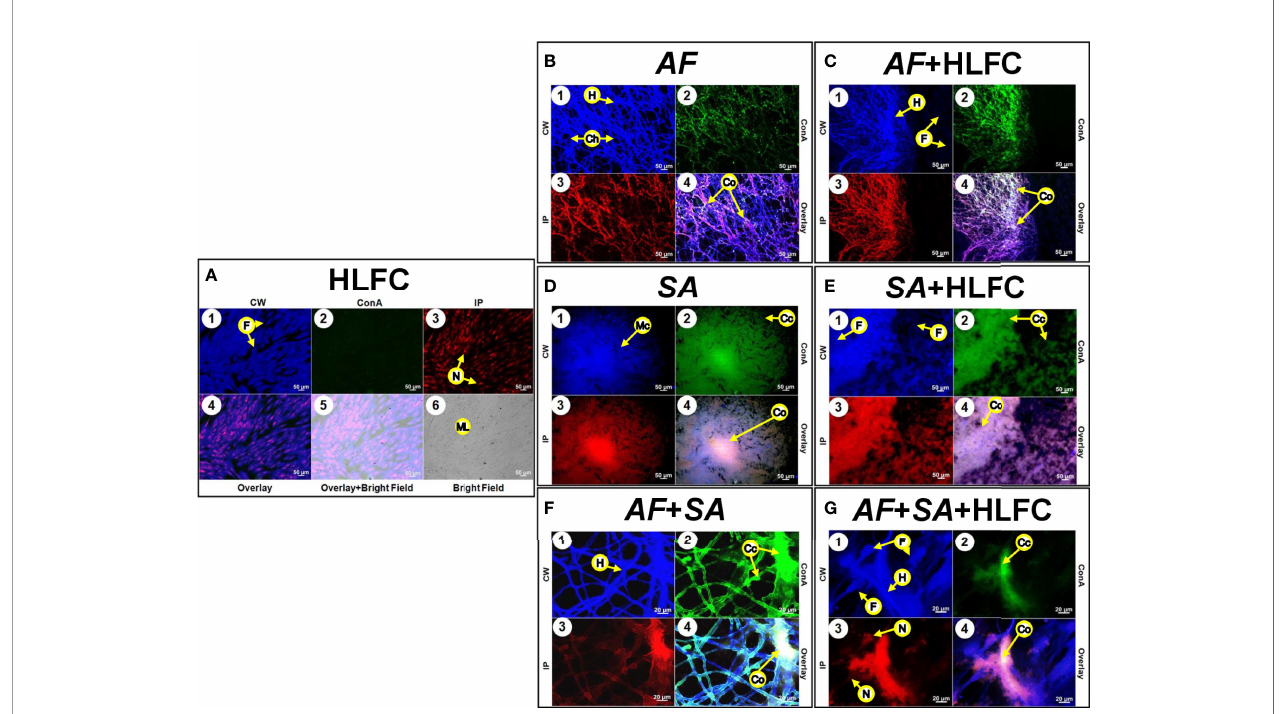
FIGURE 5 | Molecular bio fi lm components detected on HLFCs. EFM micrograph at 24 h showed ECM composition over the HLFC monolayer. HLFC ( A : 10×), AF ( B : 10×), AF+HLFC ( C : 10×), hyphal network and co-localization of carbohydrates and eDNA in the ECM. SA ( D : 10×), SA+HLFC ( E : 10×), co-localization of carbohydrates and eDNA in the center of the bacterial microcolonies growing over the fi broblasts. AF+SA ( F : 40×) and AF+SA+HLFC ( G : 40×) showed antibiosis against AF for both. Calco fl uor White (CW: blue-chitin and glycosylated carbohydrates), concanavalin A (ConA: green-glucose and mannose residues), and propidium iodide (PI: red-nucleic acids). Co-localization was obtained by image merging. HLFCs, human limbo-corneal fi broblast cells; AF, Aspergillus fumigatus ; SA, Staphylococcus aureus ; H, hypha; F, fi broblast; Ch, channels; ML, monolayer; Cc, cocci; Co, co-localization; Mc, microcolony; N,